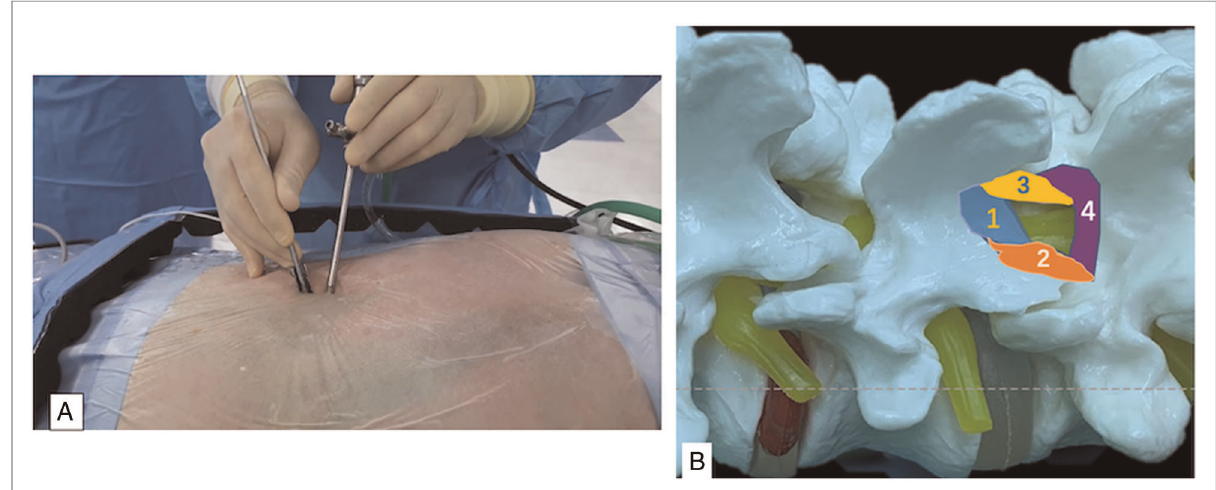
FIGURE 1 ( A ), intraoperative overview of percutaneous biportal endoscopic approach. ( B ), steps of decompression procedures: 1, spinolaminar junction fi rst, until the origin of ligamentum fl avum; 2, ipsilateral laminotomy and medial facetectomy; 3, contralateral sublaminar to lateral recess; 4. upper lamina margin of the lower